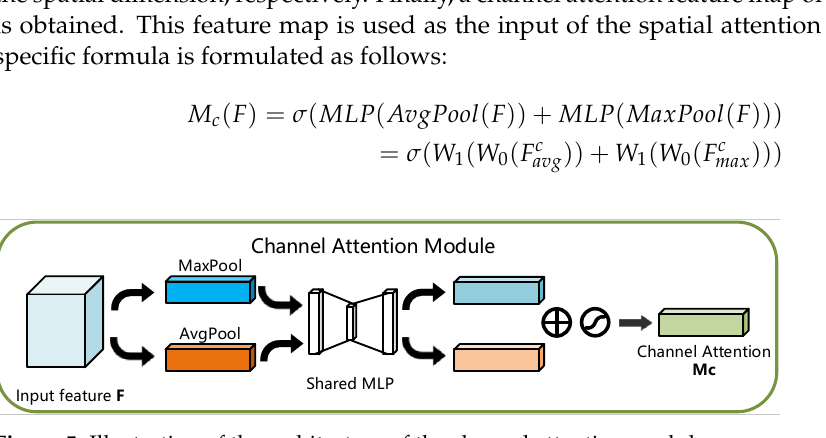
Figure 5. Illustration of the architecture of the channel attention module.